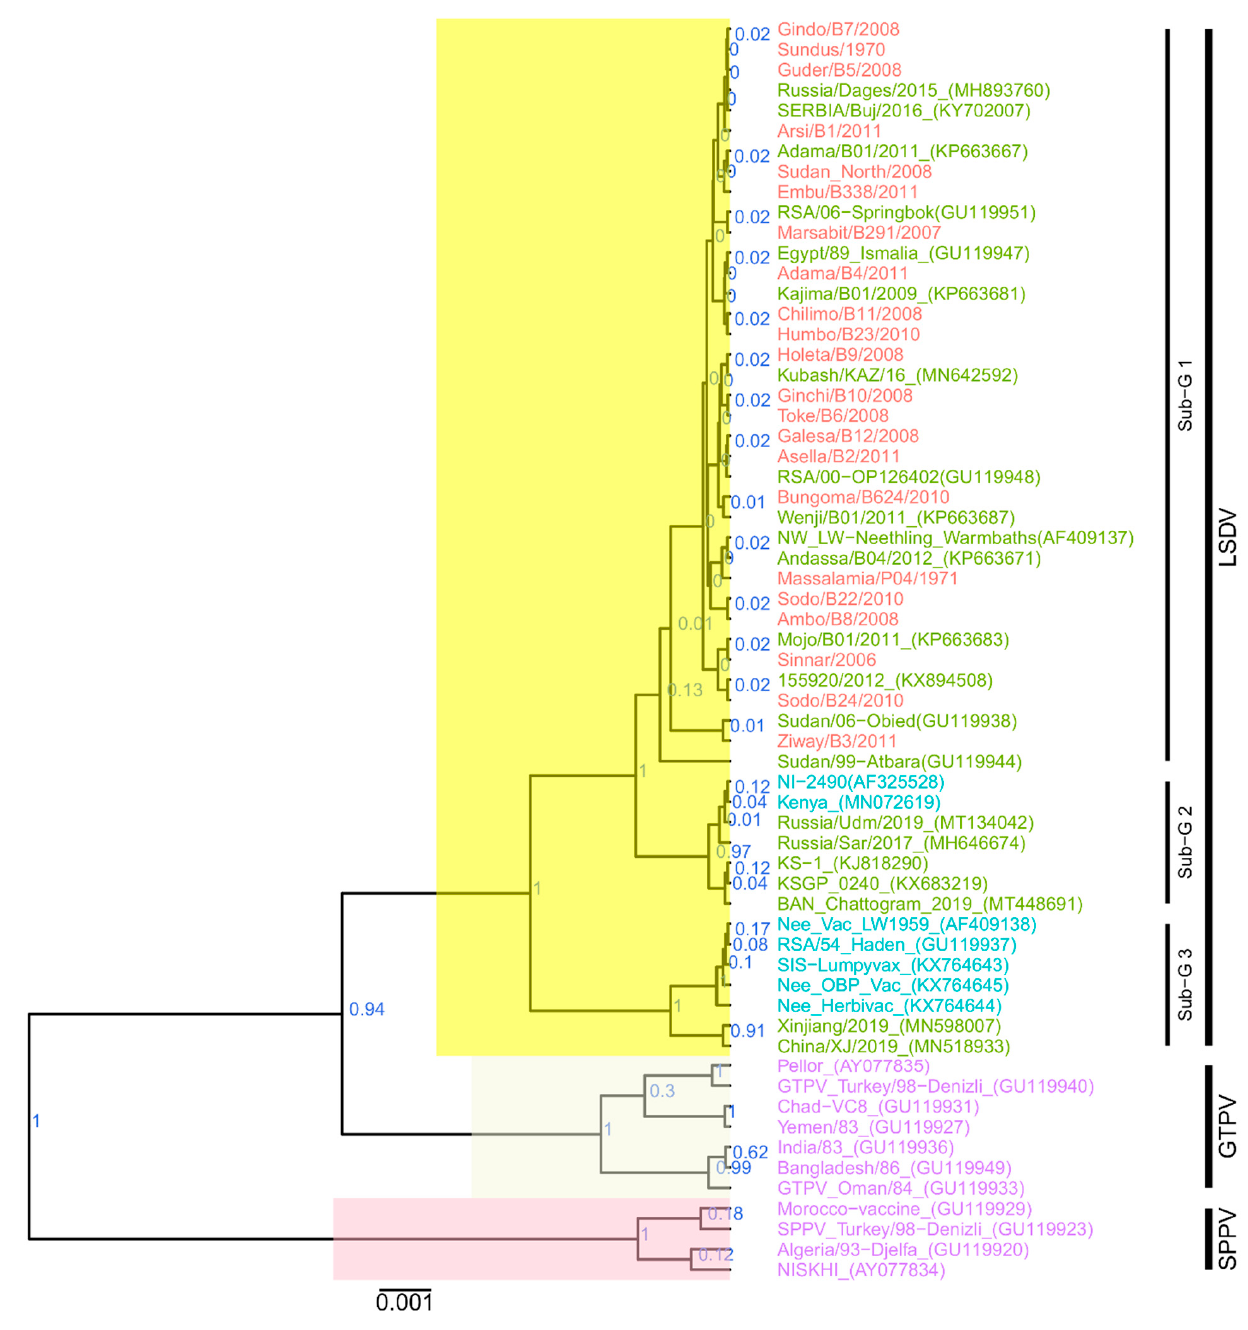
Figure 2. Maximum clade credibility (MCC) tree based on the complete RPO30 gene sequences of capripoxviruses. The posterior probabilities are plotted as respective node labels. The sequences of this study are highlighted in red, and reference sequences are represented with their accession numbers (blue for LSDVs collected before 1960 and green for those collected after 1960). SPPVs and GTPVs are shown in purple.